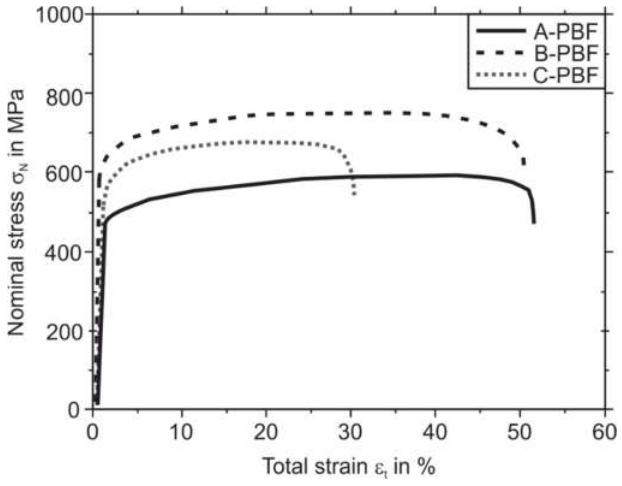
Figure 12. Stress/strain curves of the PBF-LB/M-processed T-bone samples. Table 7. Mechanical properties of the PBF-LB/M-processed samples.